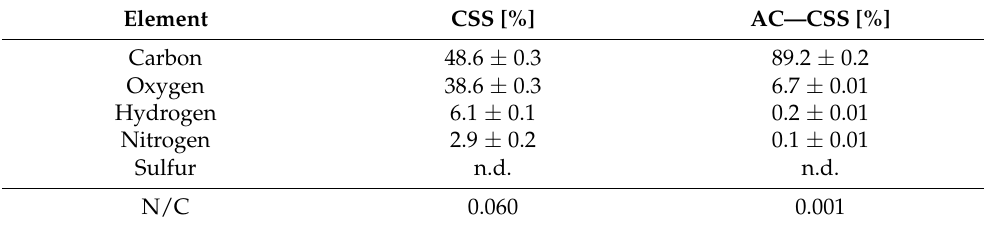
Table 1. Elemental composition (excluding ash) of CSS and AC—CSS. (n.d.: not detected).